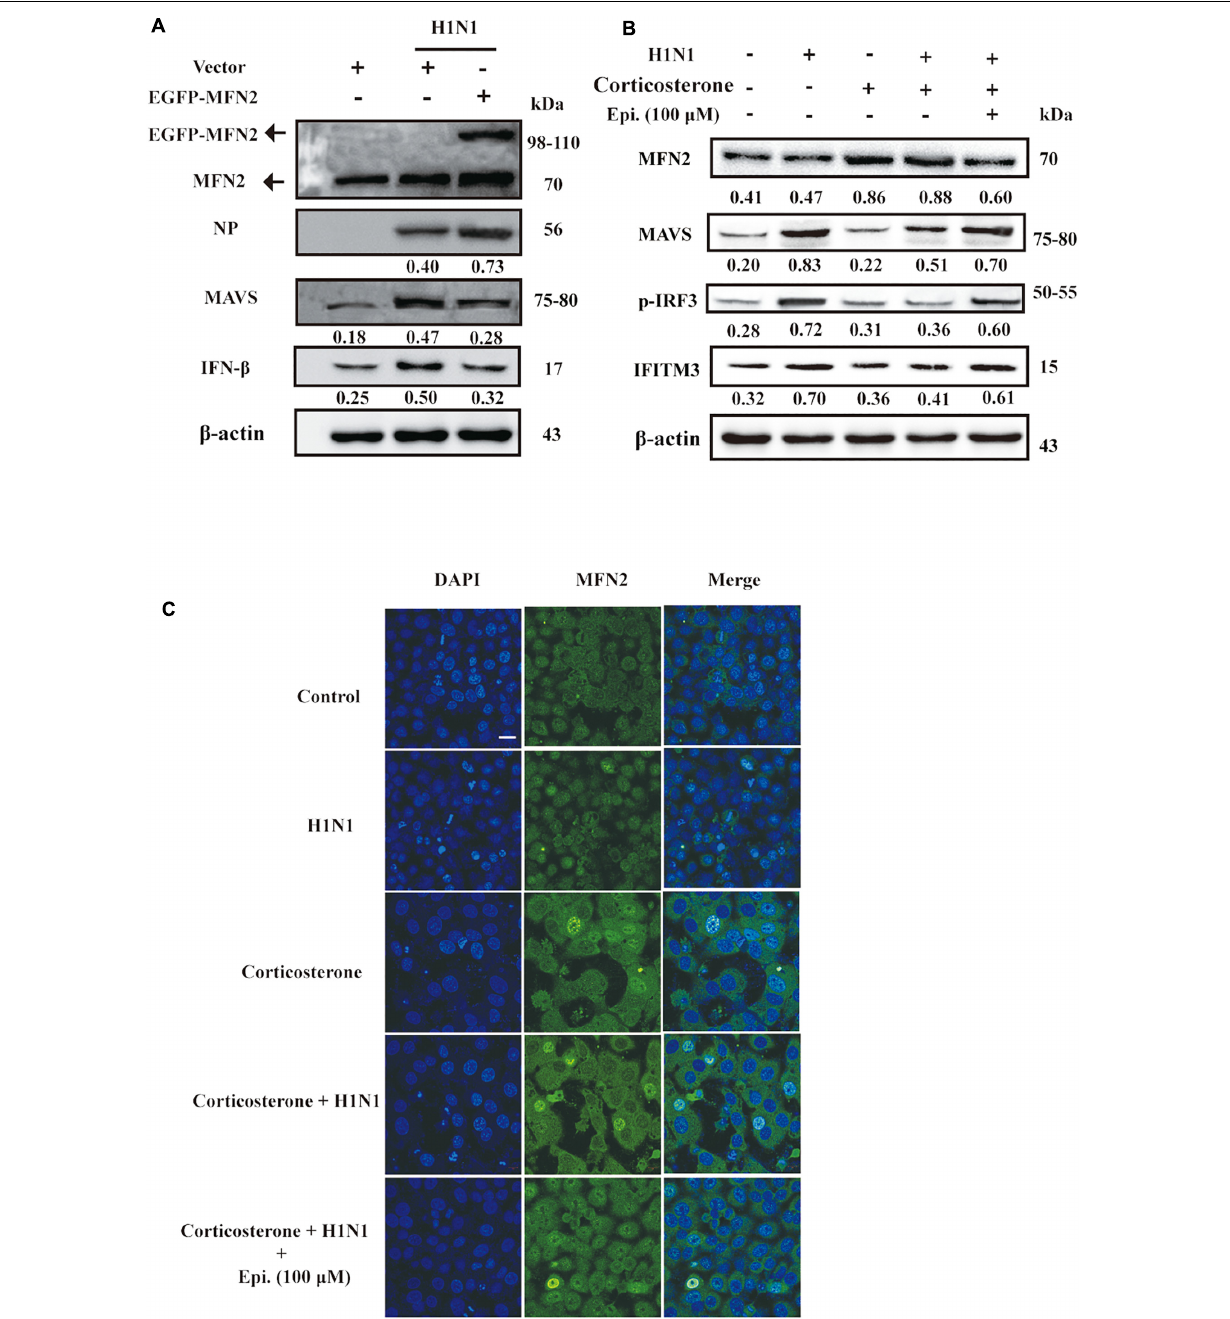
Frontiers in Pharmacology |